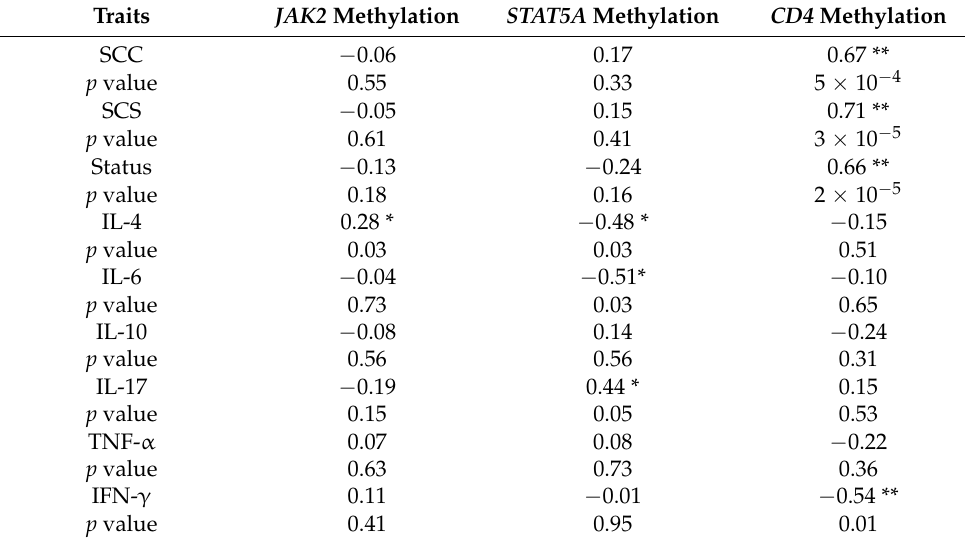
Table 3. Spearman’s correlation of DNA methylation levels with mastitis-related traits in JAK2 , STAT5A , and CD4